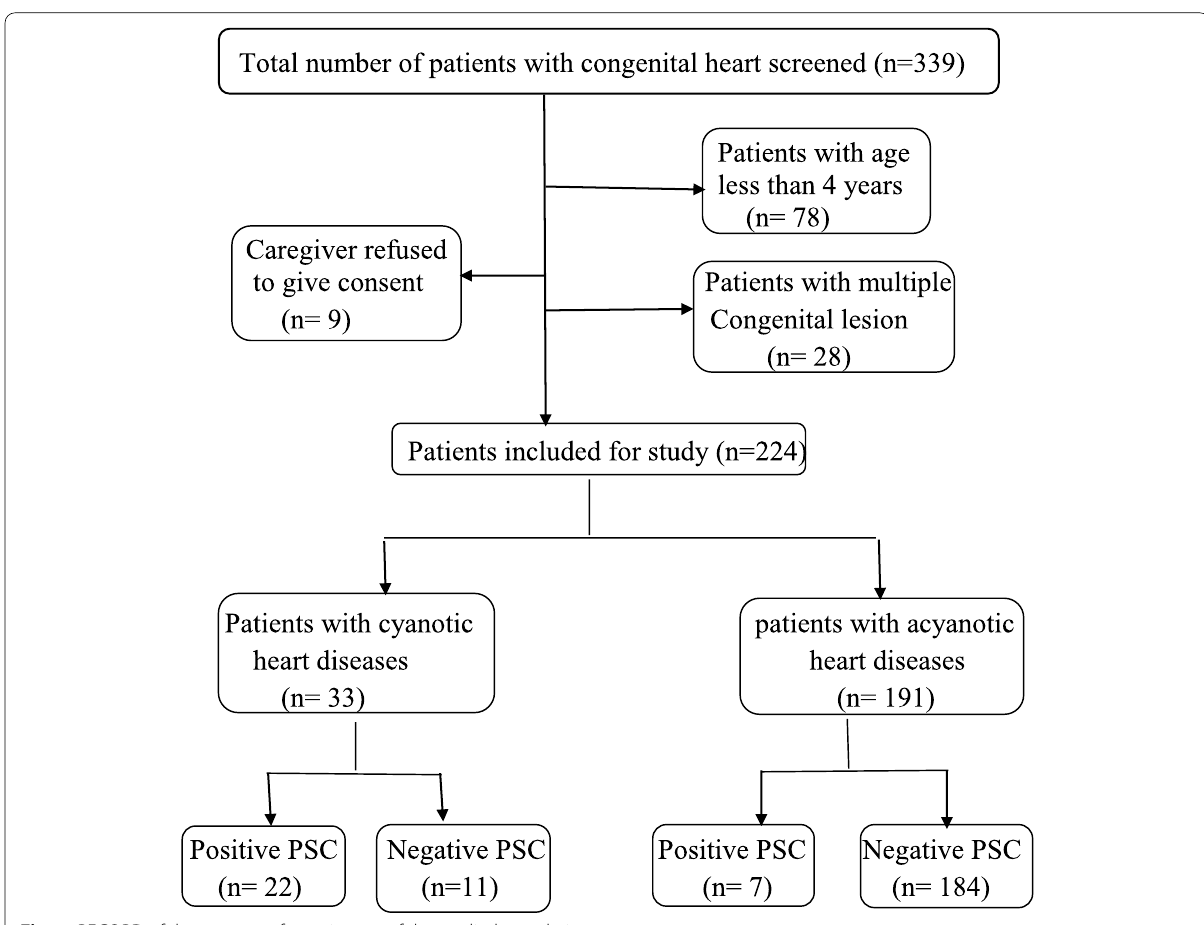
Fig. 1 RECORD of the strategy of recruitment of the studied